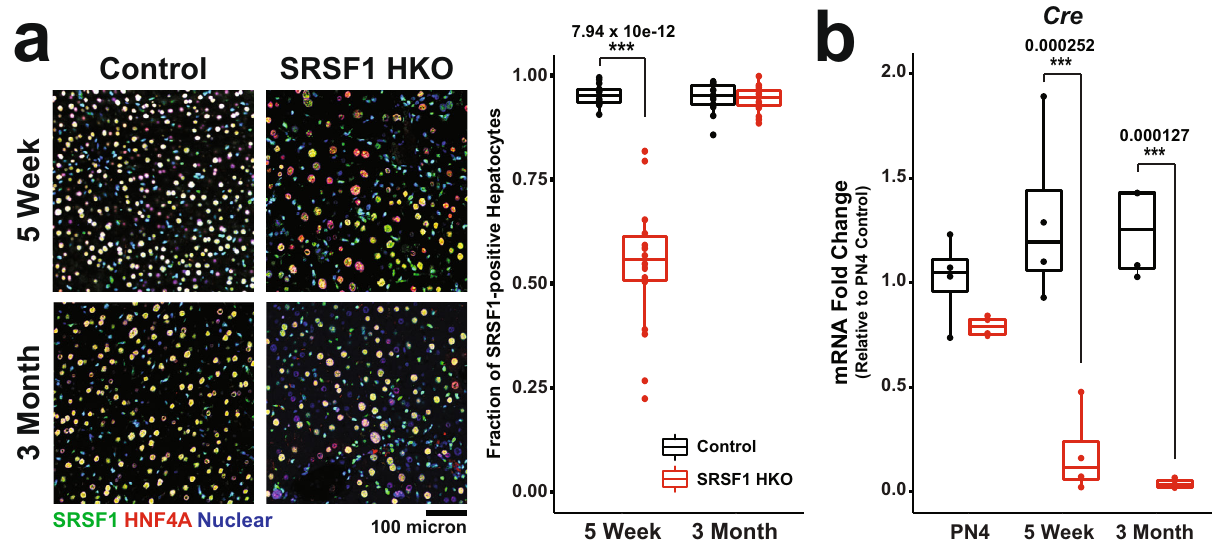
Fig. 2 | Hepatocytes in SRSF1 HKO mice eventually circumvent knockout via AlbCre repression. a Left: Representative IF images of liver sections from Control and SRSF1 HKO mice at indicated timepoints ( n =3 biologically independent ani- mals, 6 fi elds perreplicate).IF images show co-staining with SRSF1 (green),HNF4 α (red), and Nuclei (blue). Right: Quanti fi cation of the fraction of SRSF1-expressing hepatocytes per fi eld from IF images at each timepoint. b Relative mRNA